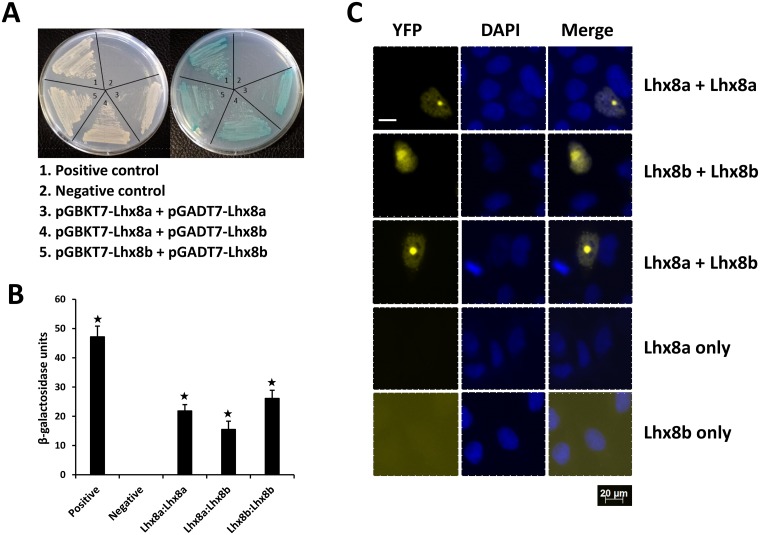
Analysis of interactions between Lhx8a and Lhx8b.A: Yeast two-hybrid analysis showing growth of yeast cells expressing BD and AD fusion proteins. Left plate: growth of yeast cells on DDO plate (medium lacking Leucine and tryptophan) showing successful co-transformations. Right plate: growth of yeast cells on selective QDO/X/A plate (quadruple drop-out medium lacking leucine, tryptophan, adenine and histidine and containing X-gal and Aureobasidin A) indicating protein-protein interactions. B: Yeast β-galactosidase liquid assays confirming protein-protein interactions. Asterisks indicate significant difference (P<0.05). C: BiFC analysis of protein-protein interactions. HEK293 cells were co-transfected with equal amounts of BiFC expression constructs encoding VN-Lhx8a and VC-Lhx8a, or VN-Lhx8b and VC-Lhx8b, or VN-Lhx8a and VC-Lhx8b fusion proteins. Single transfections using constructs encoding either VN-Lhx8a or VN-Lhx8b were served as negative controls. YFP signals due to BiFC were measured by fluorescence microscopy. Scale bars, 20 μm.